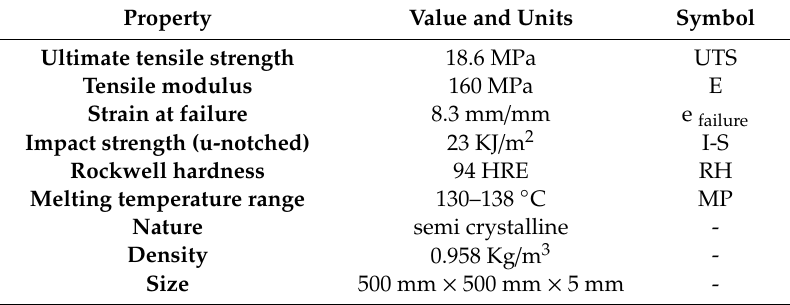
Table 1. Properties of the Base Material.